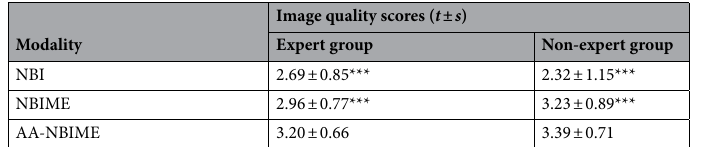
Table 7. Comparison of the image quality among NBI, NBIME, and AA-NBIME. ***AA-NBIME, NBIME versus NBI P < 0.001, ***AA-NBIME versus NBIME P <